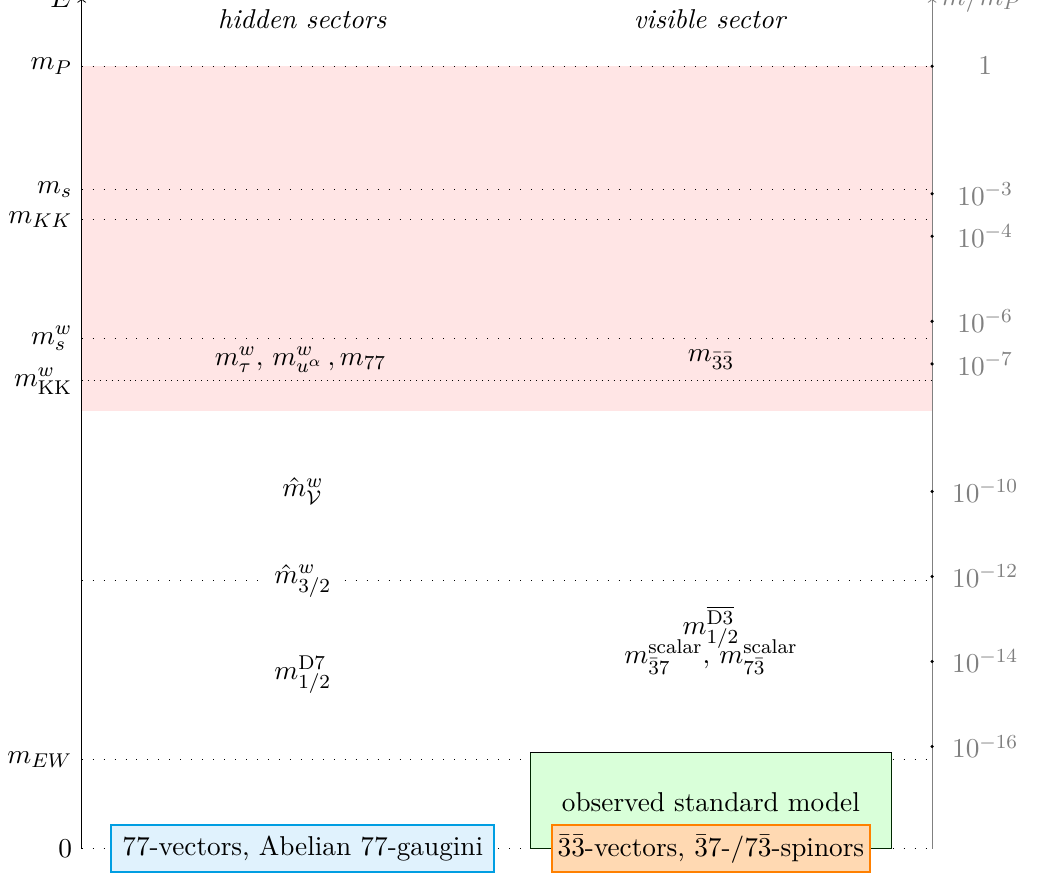
∼ 0 . 3 and D3 ∼ g 2 and m D7 ∼ m D3 . D7 1 / 2 1 / 2 D3